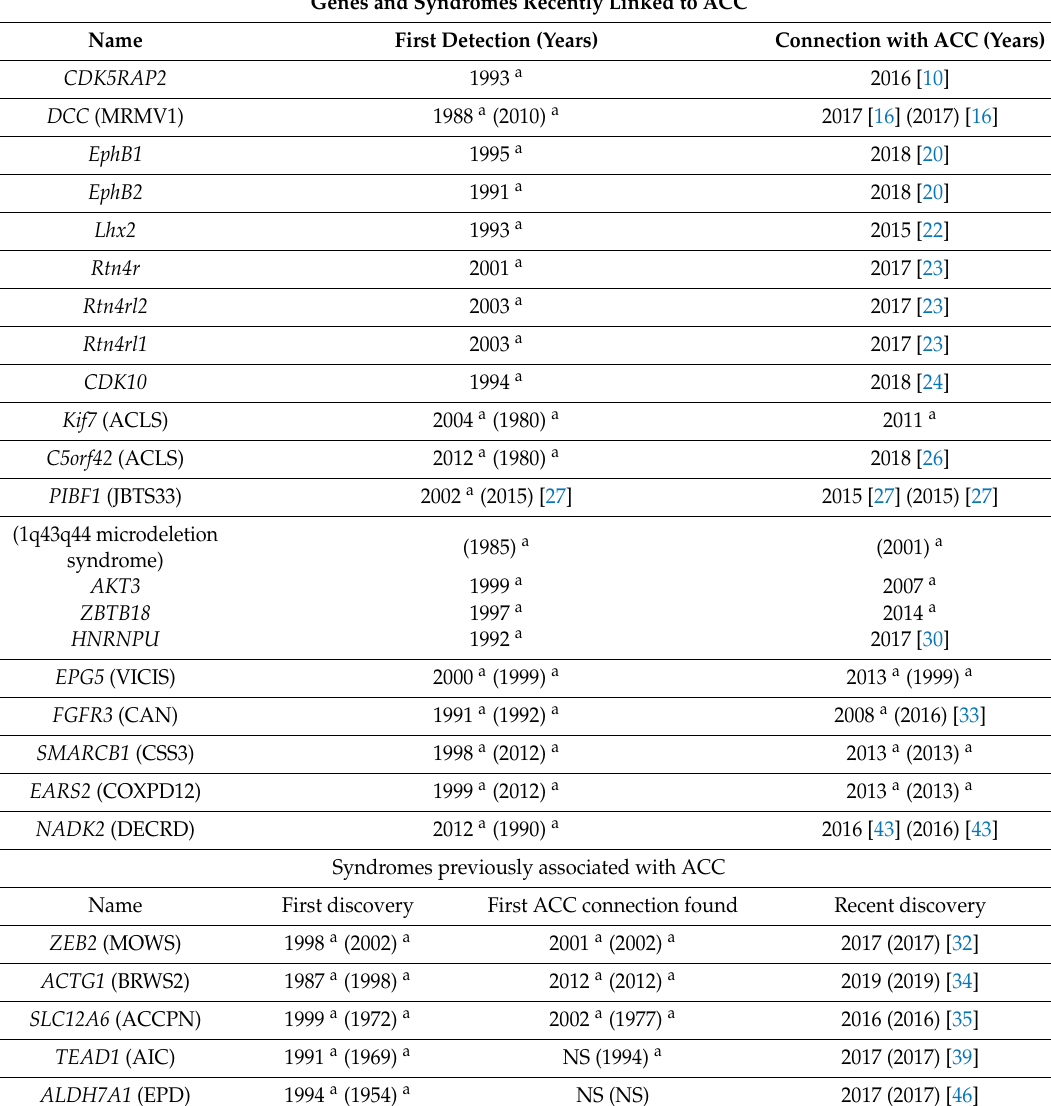
Table 2. Comparison of recently discovered genes and syndromes linked to ACC and previously known syndromes resulting in